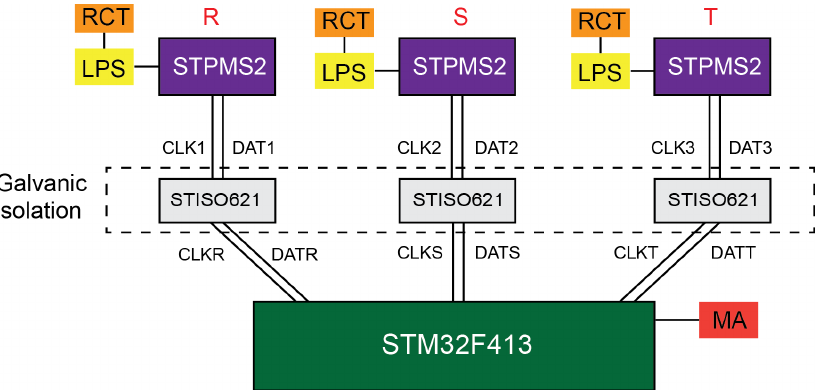
Figure 40. Three-phase meter block diagram with sigma–delta modulators (RCT—rectifier, LPS— linear power supply, MA—mains adapter).